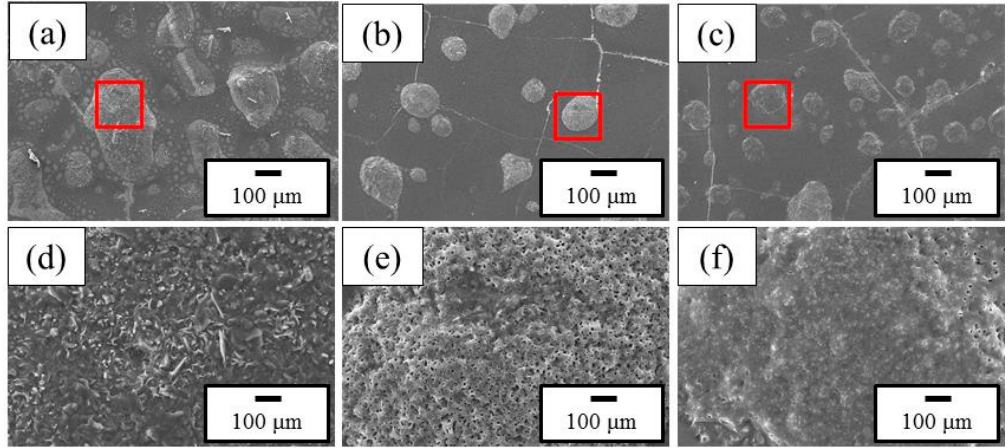
Figure 5. Surface morphology of MoSi 2 -coated TZM alloys oxidized at 1350 °C for ( a ) 5, ( b ) 20, and ( c ) 50 h; ( d – f ) show the enlargements of the marked areas in ( a – c ), respectively.